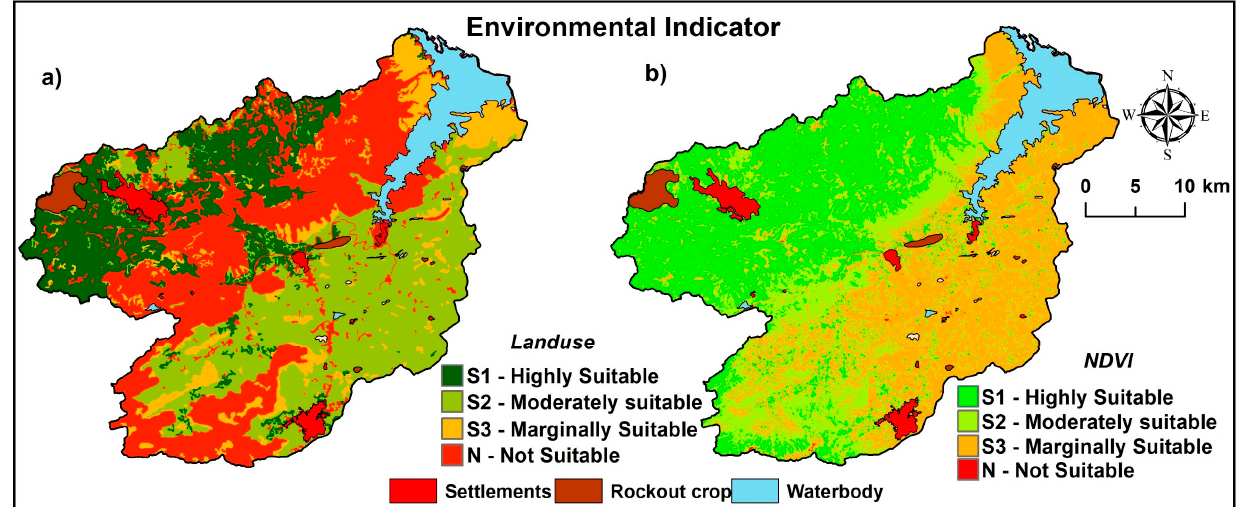
Figure 5. Suitability classes of environmental indicators: ( a ) land use and ( b ) NDVI.